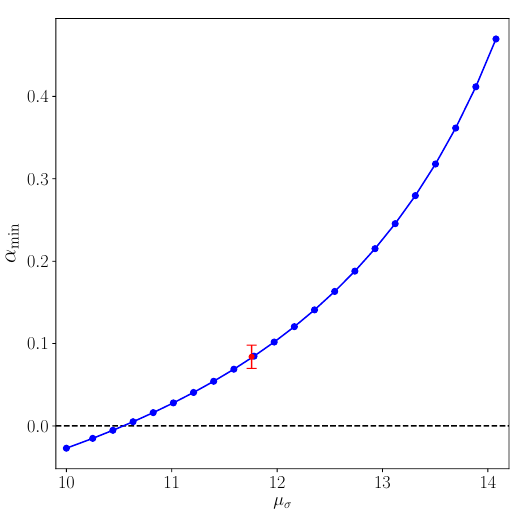
Figure 11: Lower bound on α ( 4 ) as a function of the imposed value of µ σ (in eq. (54)), in an interval chosen so that it contains the zero of α . The red point and min the errorbar correspond to µ σ , which gives α ( 4 ) ≥ 0.084 ( 14 ) . The reported ,trunc. error comes from the uncertainties in ∆ φ and ∆ ε